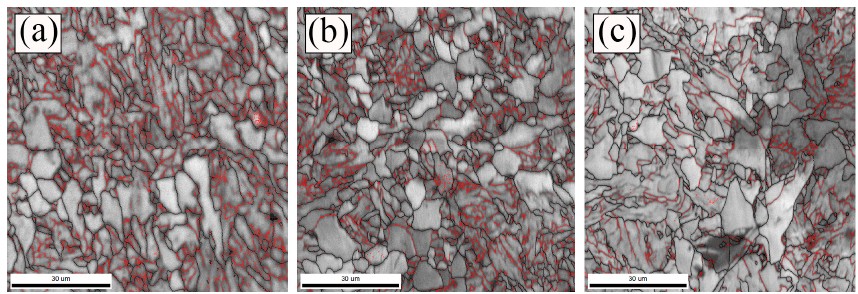
Figure 7. EBSD IPF maps for different CP samples at CP-A ( a ), CP-C ( b ), and CP-E ( c ) with the misorientation angle ranging from 2 ◦ to 15 ◦ and higher than 15 ◦ is indicated by the white and black lines, respectively. IPF—inverse pole figures, CP—cooling path. Table 2. Microstructural observation and quantification results for different CP samples.